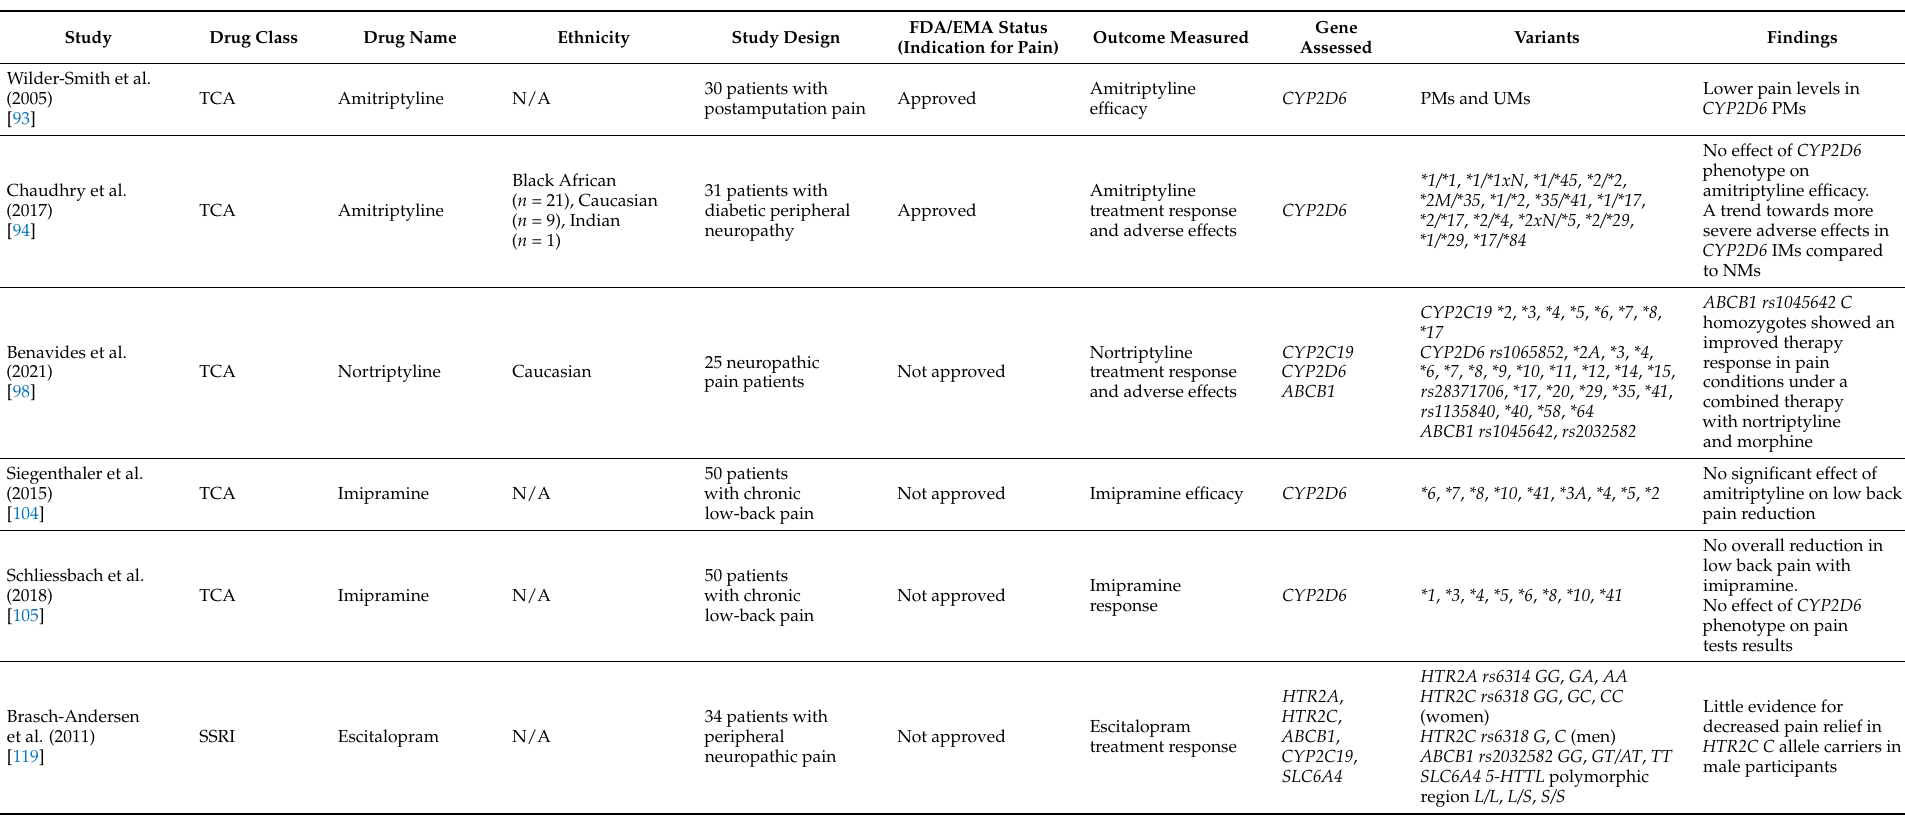
Table 3. Studies investigating the association between pharmacogenetics and the effect and safety of antidepressants in pain in vivo (human